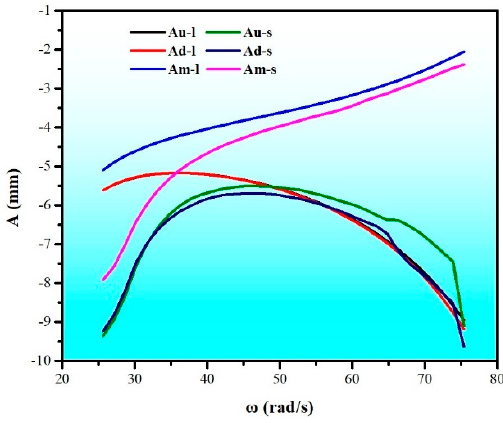
Figure 14. Amplitude − frequency characteristics curves comparison of the theoretical and experimental